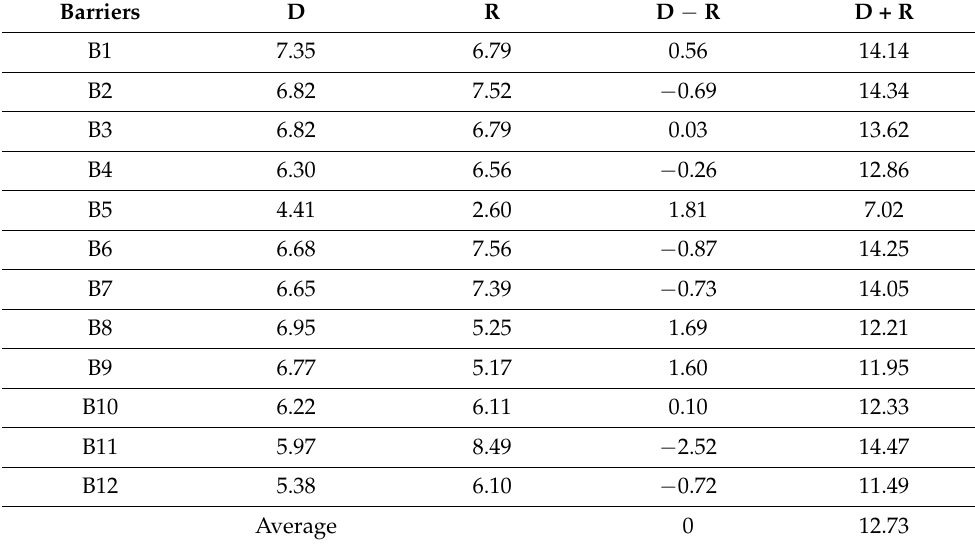
Table 8. Prominence and relation results obtained by using the DEMATEL method.